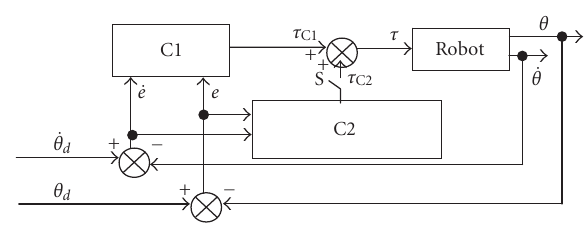
Figure 16: Hybrid fuzzy